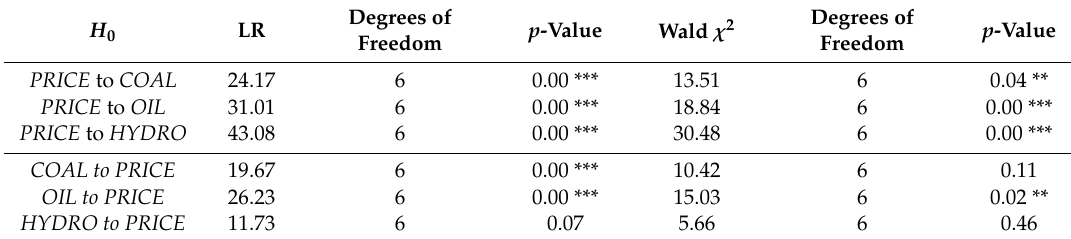
Table 9. Granger causality